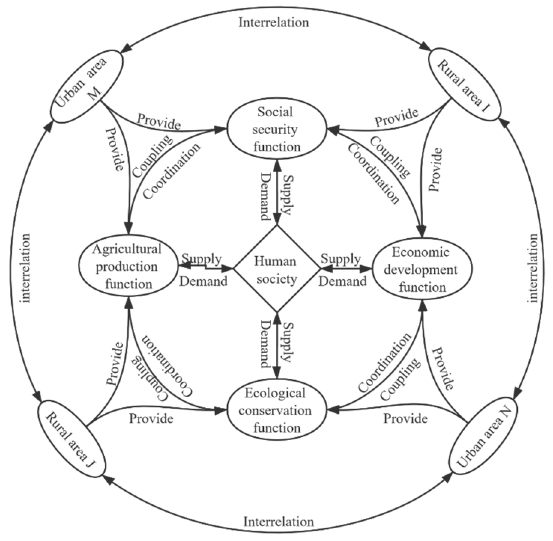
Figure 1. Linkage role of LUFs in the human–land system.